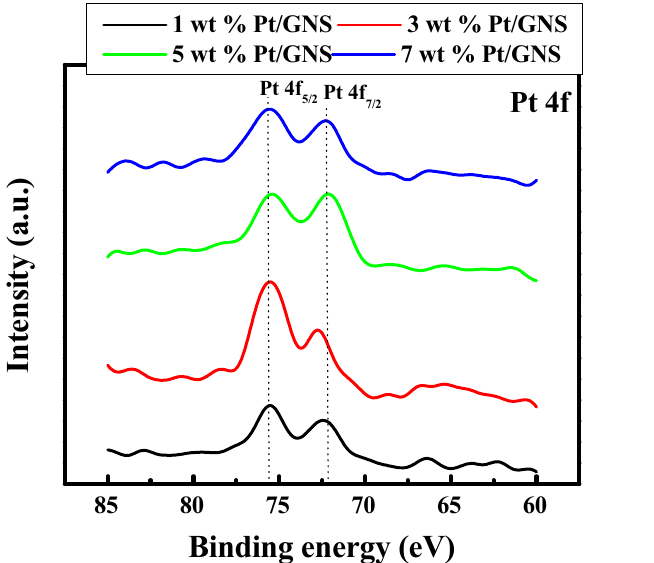
Figure 7. XPS Pt spectra of 1–7 wt.% Pt/GNS (Narrow